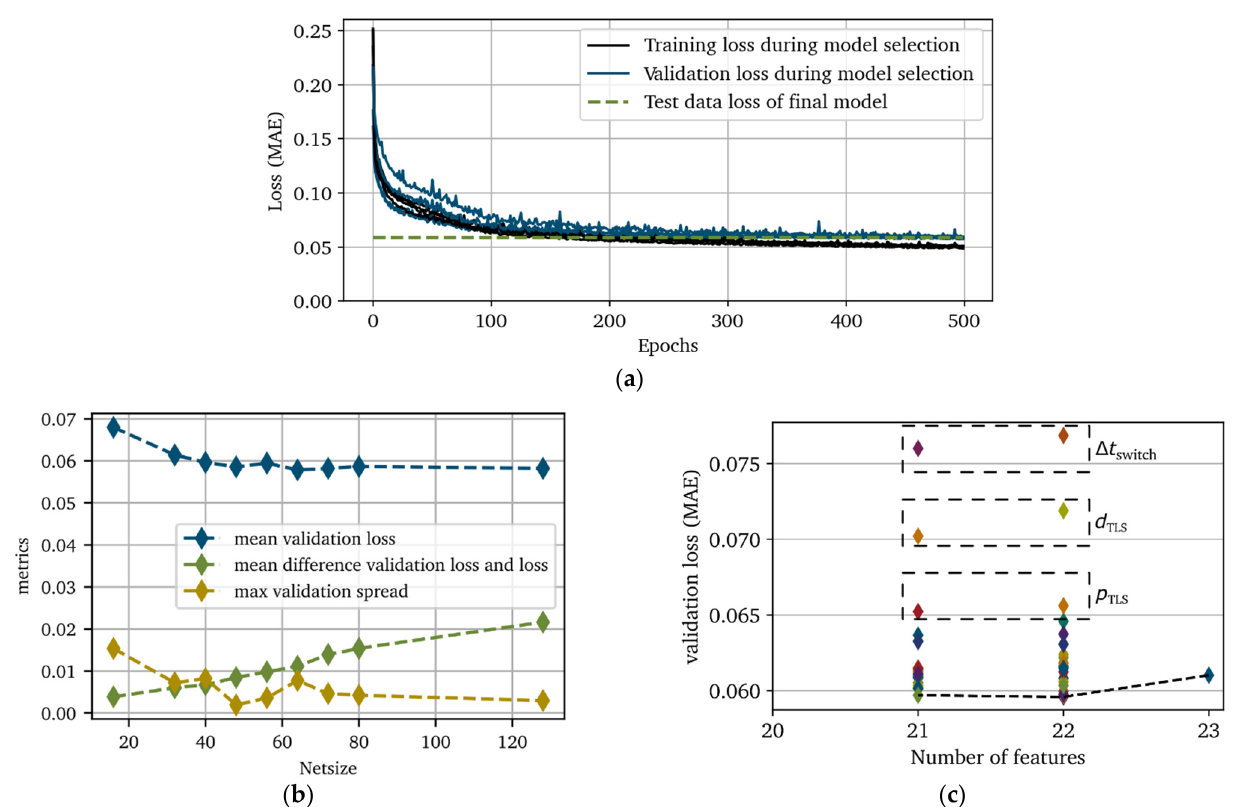
Figure 9. Results of the model selection process. In ( a ), the training and validation losses for the selected net size are displayed. The model assessment metrics as a function of net size are shown in ( b ) and the results of the feature wrapping subprocess are shown in ( c ).